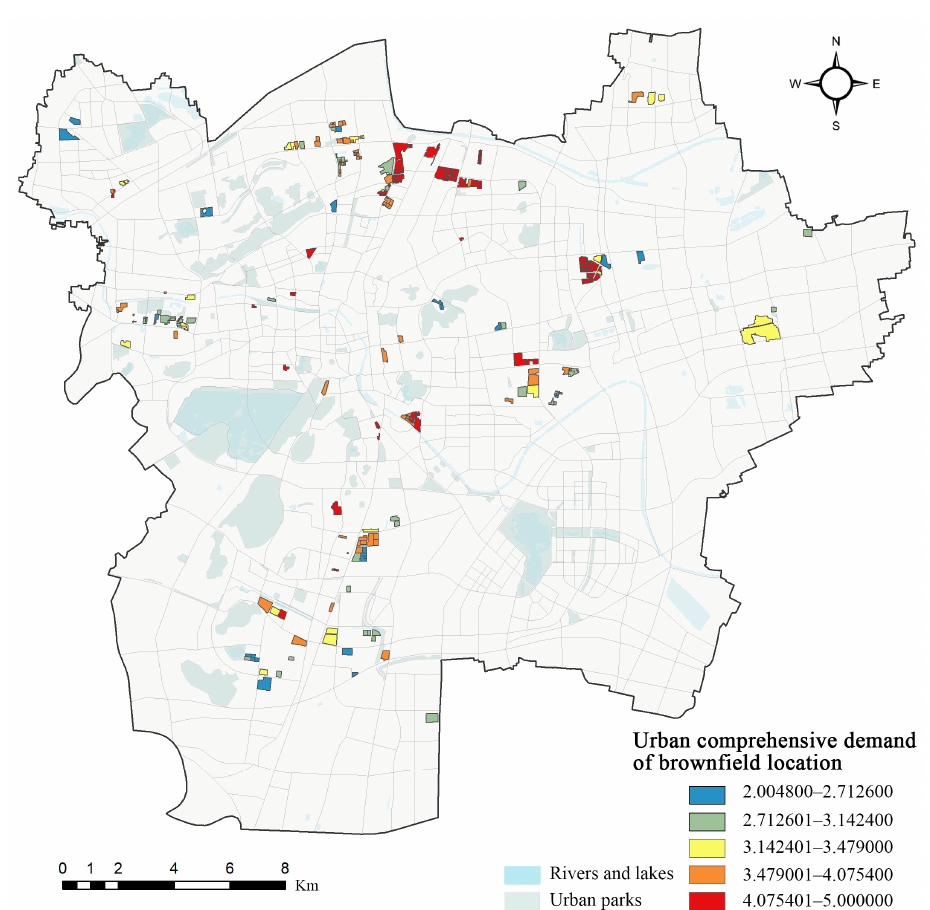
Figure 5. Values of comprehensive urban demand in the brownfield location.